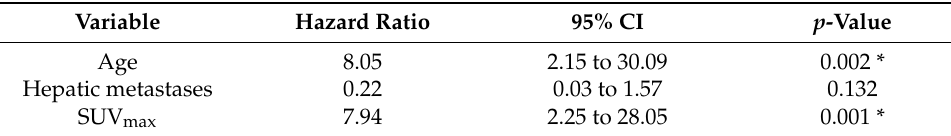
Table 3. Multivariate logistic regression analysis.